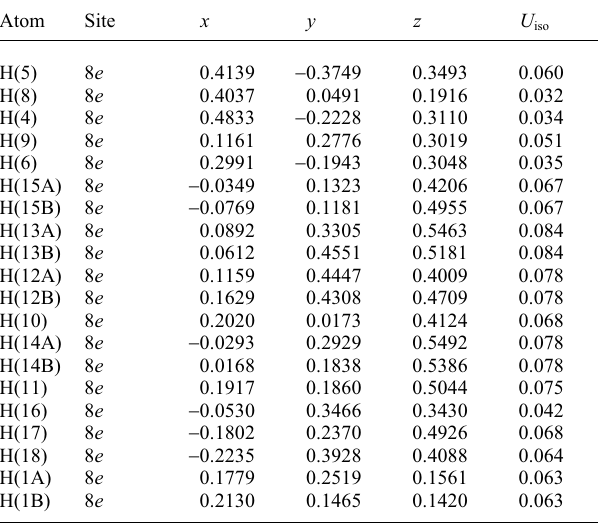
Table 2. Atomic coordinates and displacement parameters (in Å 2 )